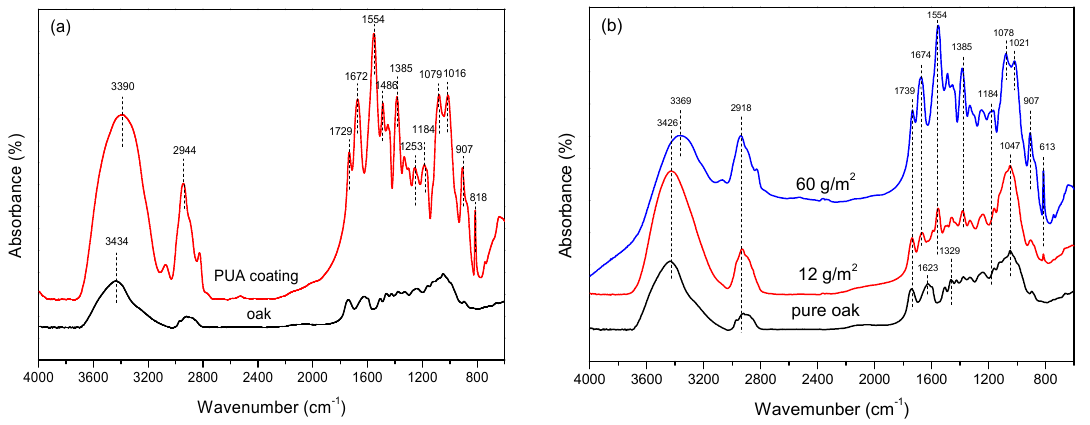
Figure 5. ATR-FTIR spectrum of samples. ( a ) Pure oak and PUA coating; ( b ) oak before and after coating with different coating amounts.